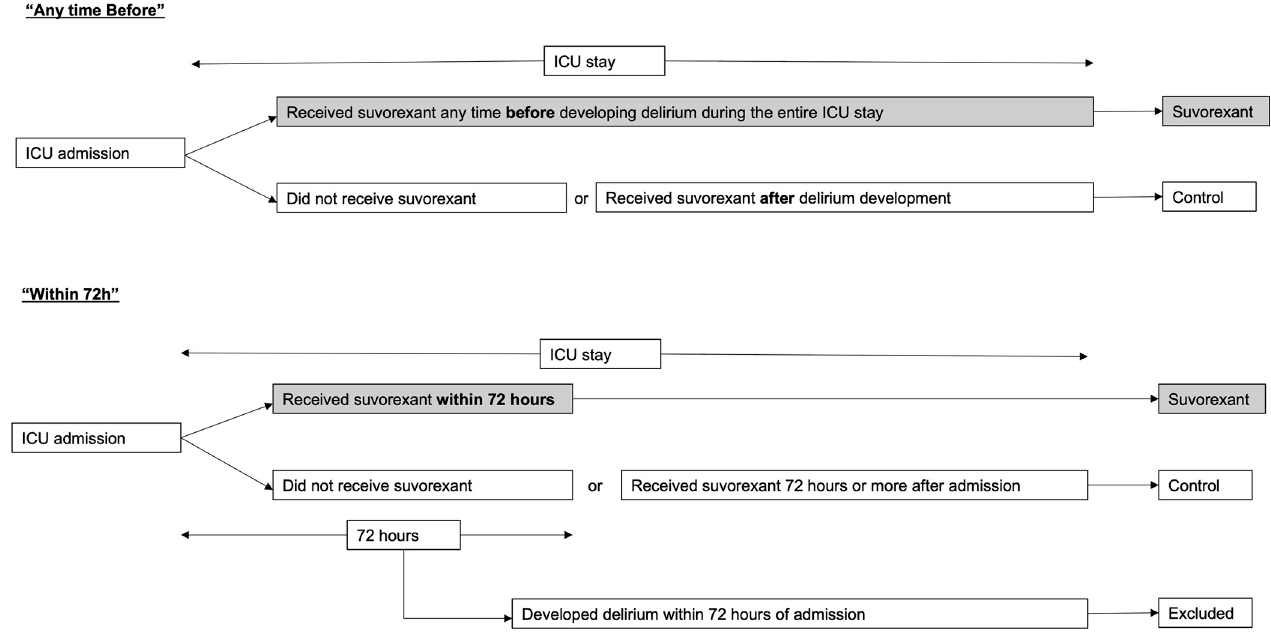
Fig 1. Patient allocation flow. a. Patient allocation flow: “Any time before” analysis. b. Patient allocation flow: “Within 72h” analysis.